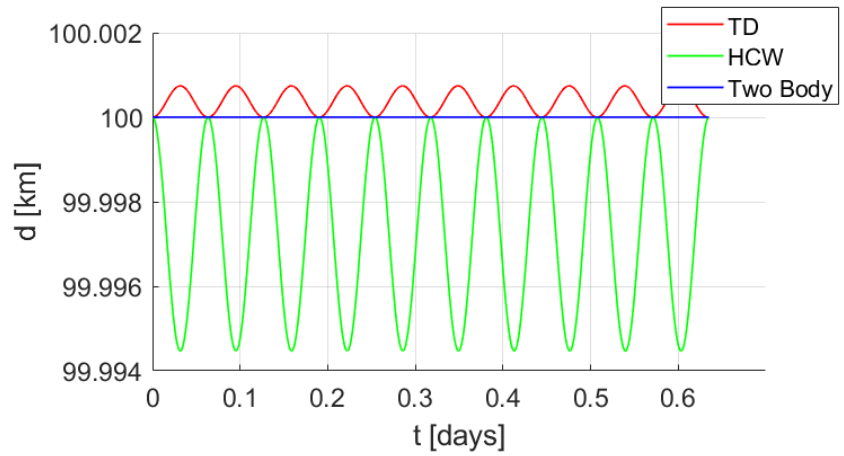
Figure 3. Inter-satellite distance for reference orbit.